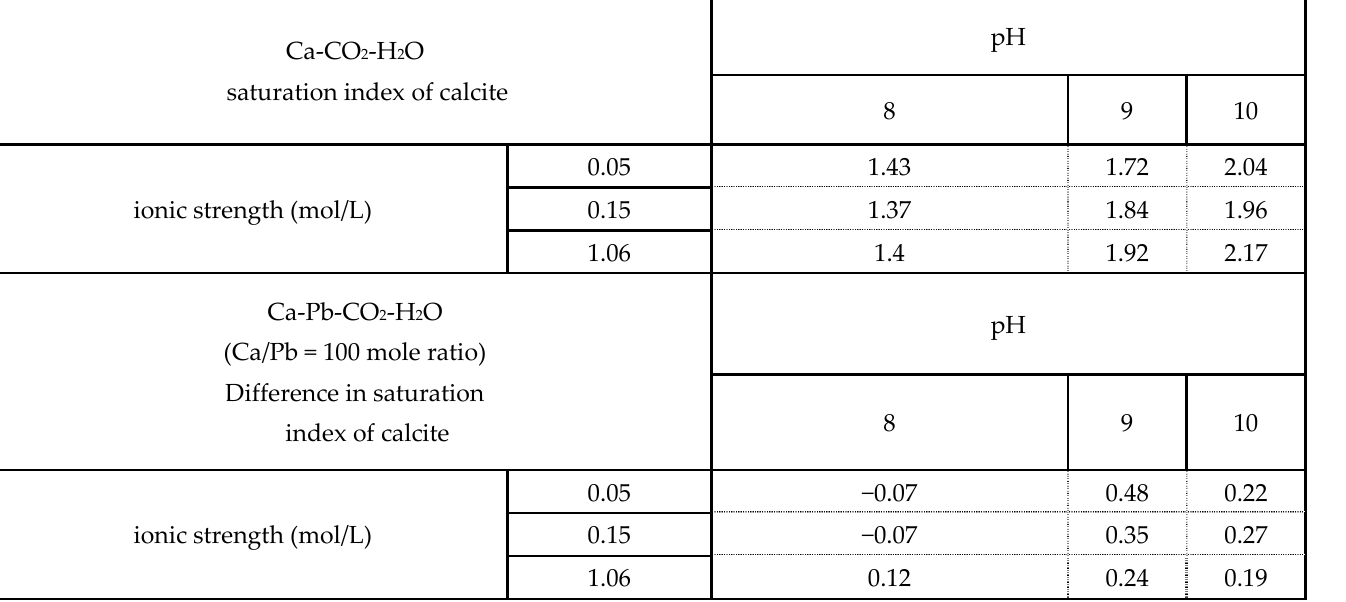
Figure 7. ( A ) Saturation index of calcite at the nucleation stage for the experiments in the presence of Pb II , 1 mol% concerning calcium. ( B ) Difference between the saturation indexes of calcite in the experiments with Pb 2+ minus the saturation index in the pure system. This plot can be considered a possible correction factor for Figure 5 to predict the formation of CaCO 3 in a system containing Pb 2+ . The possibility to derive similar corrections factors to include the effect of other variables could substantially contribute to the prediction of CaCO 3 in real systems. Table 2. Saturation indexes of calcite at the nucleation stage in the pure system and correction factors for the presence of 1 mol% of Pb 2+ . The data correspond to the values plotted in Figures 5 and 7B.